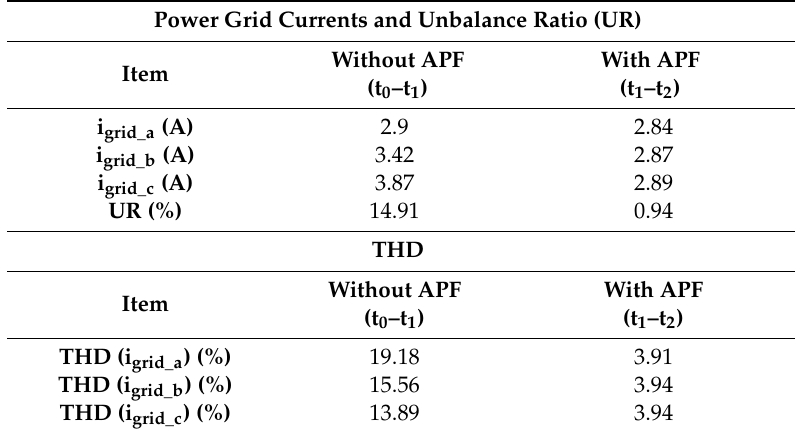
Table 2. Root-mean-square (RMS) currents and total harmonic distortion